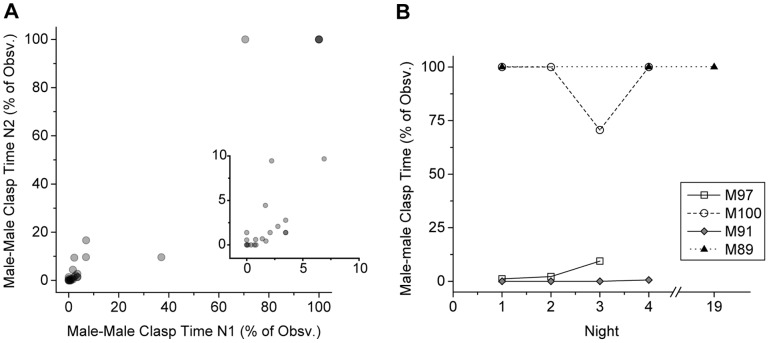
Clasping behavior within male-male pairs is repeated reliably from night to night.
A. Clasping behavior was observed for one randomly selected male in each pair for two subsequent nights (N1 and N2). Behavior on the two nights was strongly correlated (Spearman correlation coefficient = 0.8783, p<0.001, n = 25). Darker gray symbols indicate multiple, overlapping data points (e.g., there are three data points at 100,100). Inset shows an expansion of the 0–10% range. B. Four pairs of frogs were observed on more than two nights, either 3–4 subsequent nights (M97, M100 and M91) or three nights spaced over nearly 3 weeks (males were returned to their separate home tanks between night 4 and night 19). Again, we saw consistent behavior.